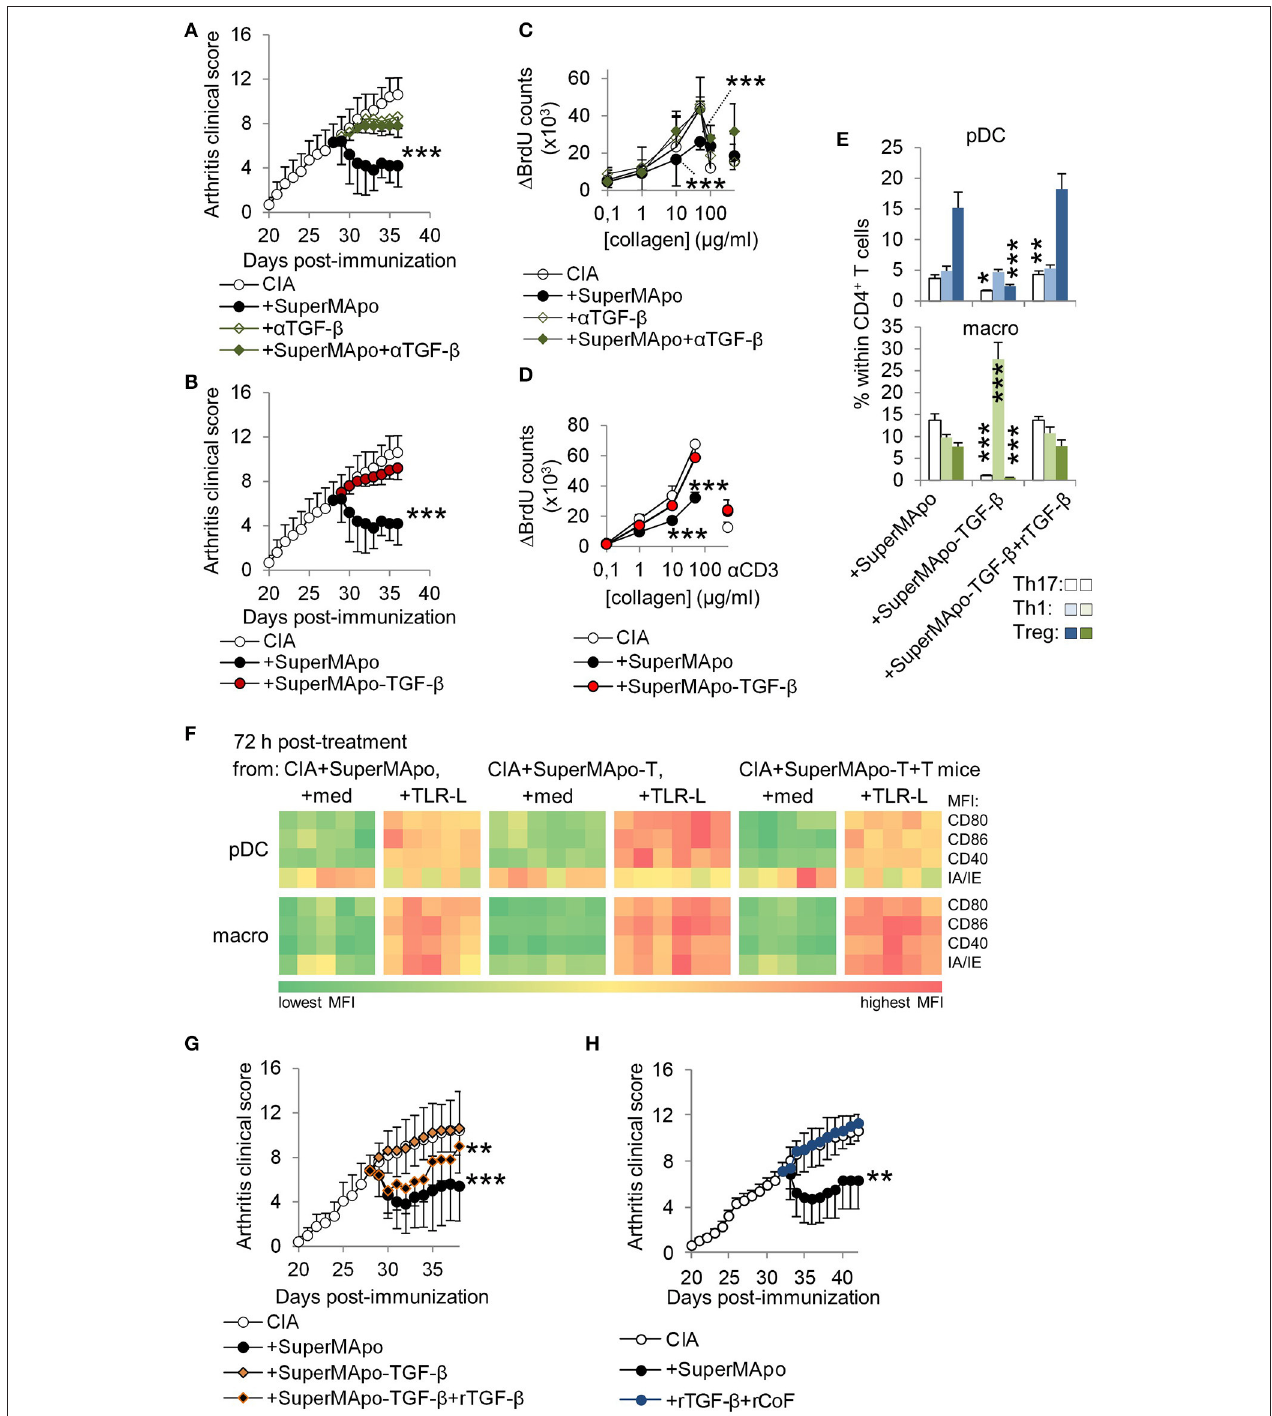
FIGURE 5 | TGF- β associated with soluble factors within SuperMApo demonstrates pro-resolutive properties. (A,B) Arthitis clinical scores showing the role of TGF- β within SuperMApo on arthritis evolution through TGF- β neutralization ( + α TGF- β ) or depletion (-TGF- β ) from SuperMApo. *** P < 0.001 vs. CIA (5 mice per group, mean ± s.e.m.), one-way ANOVA with Bonferroni’s multiple comparison post-tests. (C,D) BrdU counts showing the proliferation of cells from arthritic mice from panels A,B . Data are shown as mean ± s.e.m. of mouse spleen cells performed in triplicates, 5 mice per group, *** P < 0.001, 2-way ANOVA with Bonferroni post-tests. (E) IL-17A + Th17, IFN- γ + Th1 and Treg CD4 + T cell polarization by pDC or macrophages isolated from mice from B and/or G (bars represent mean ± s.e.m. of triplicate